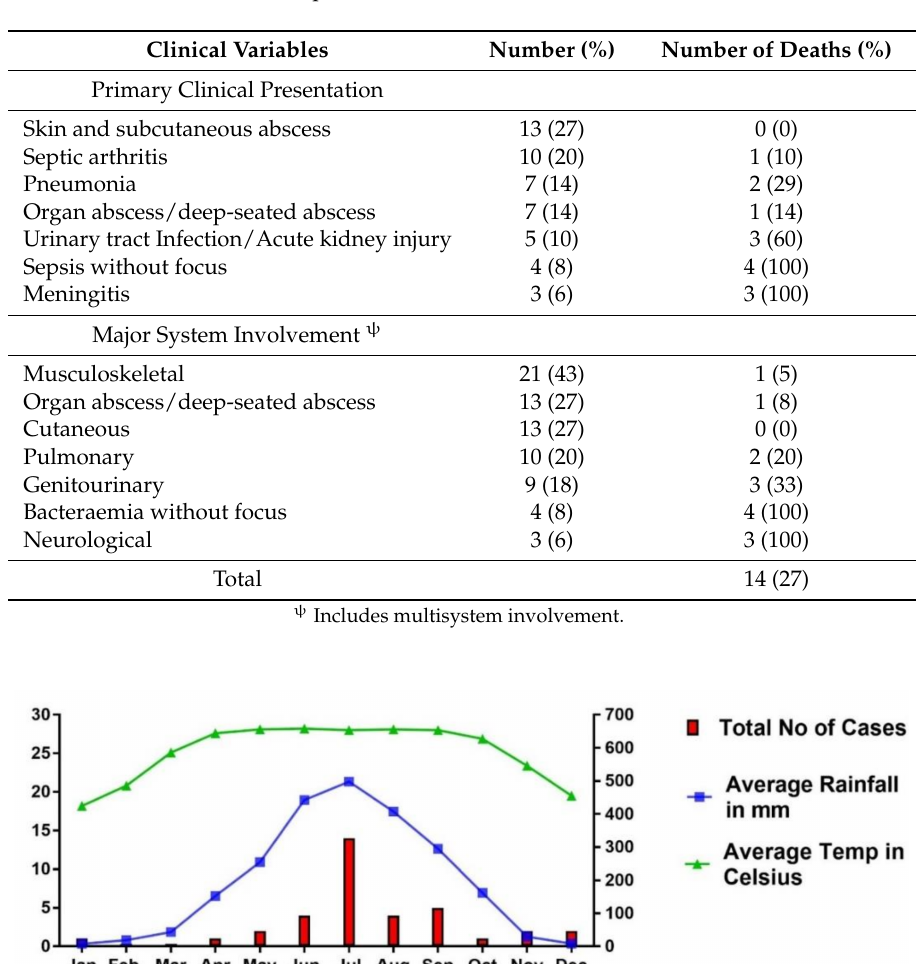
Table 4. Clinical description of culture-confirmed melioidosis cases ( n = 49).